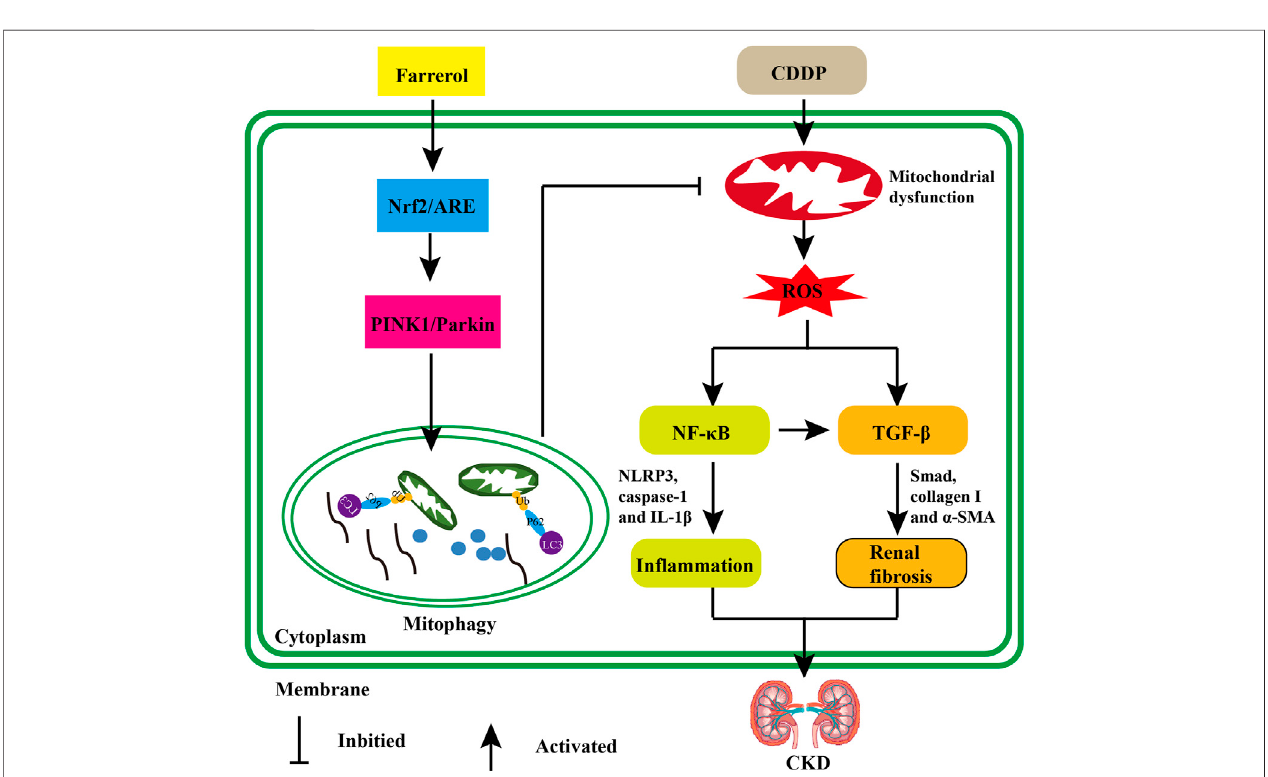
Frontiers in Pharmacology |